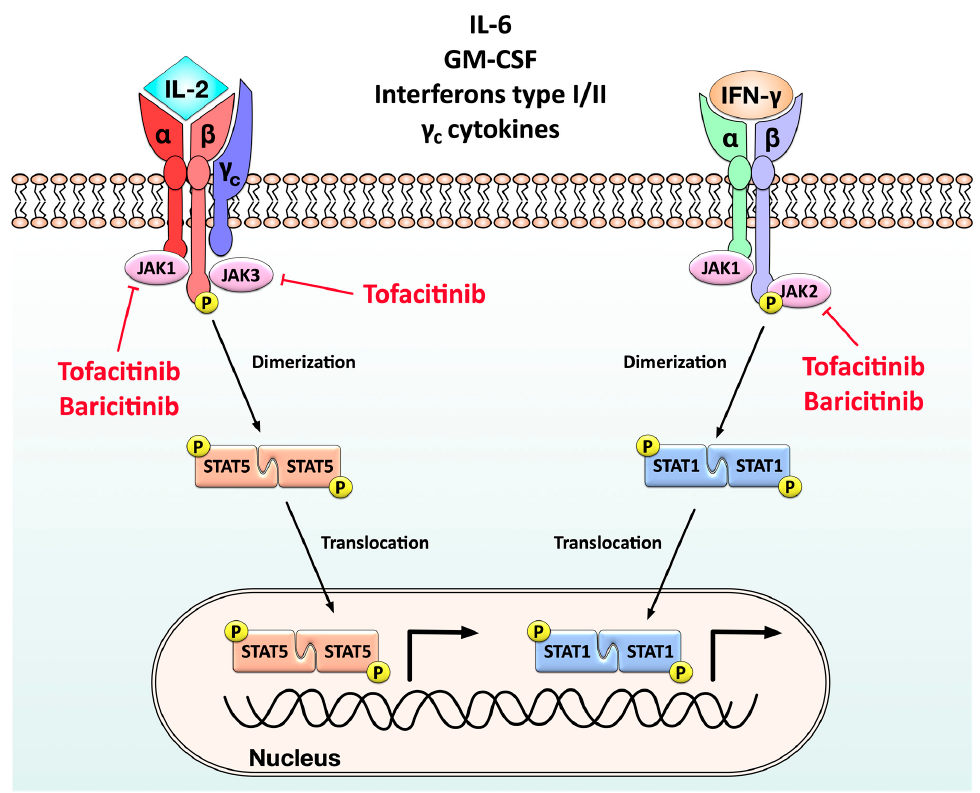
Figure 6. Molecular mode of action of Janus activated kinase (JAK) inhibitors. Binding of pro-inflammatory cytokines (e.g., IL-6, common γ -chain-containing cytokines (e.g., IL-2 or IL-15), type I and II interferons, or granulocyte-monocyte colony stimulating factor (GM-CSF)) to their respective receptors on the surface of immune cells triggers the recruitment of JAKs. JAKs subsequently phosphorylate the intracytoplasmic parts of the respective receptors, inducing the phosphorylation, auto-homodimerization, and nuclear translocation of different signal transducer and activator of transcription (STAT) molecules. In the respective cell’s nucleus STAT dimers promote the expression of many pro-inflammatory genes that initiate and sustain joint inflammation and tissue damage. The targeted DMARDs tofacitinib and baricitinib inhibit this activation of JAKs and thereby prevent immune cell activation and subsequent inflammatory responses.